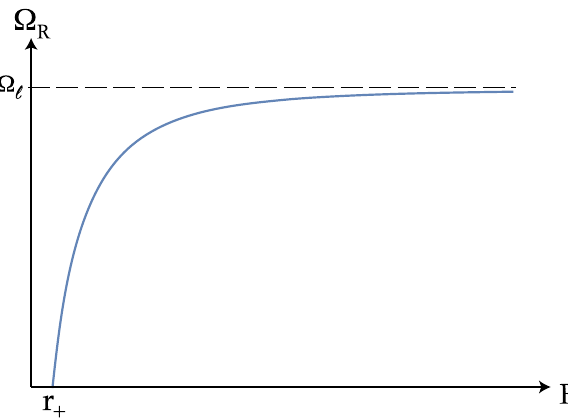
Fig. 7 Plot for the maximum angular velocity Ω R as a function of the radius of the orbit R for an interferometer in the Sagnac